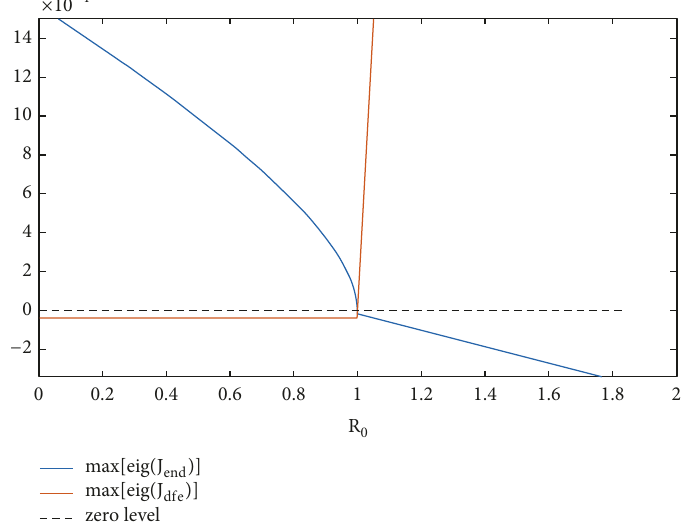
Figure 1: Maximum Eigenvalues of the Jacobians of the model of Example 6.